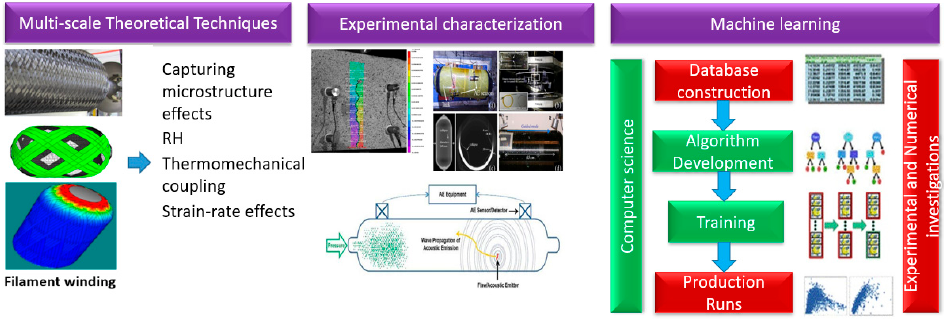
Figure 28. Machine learning fast prediction using numerical and experimental results.